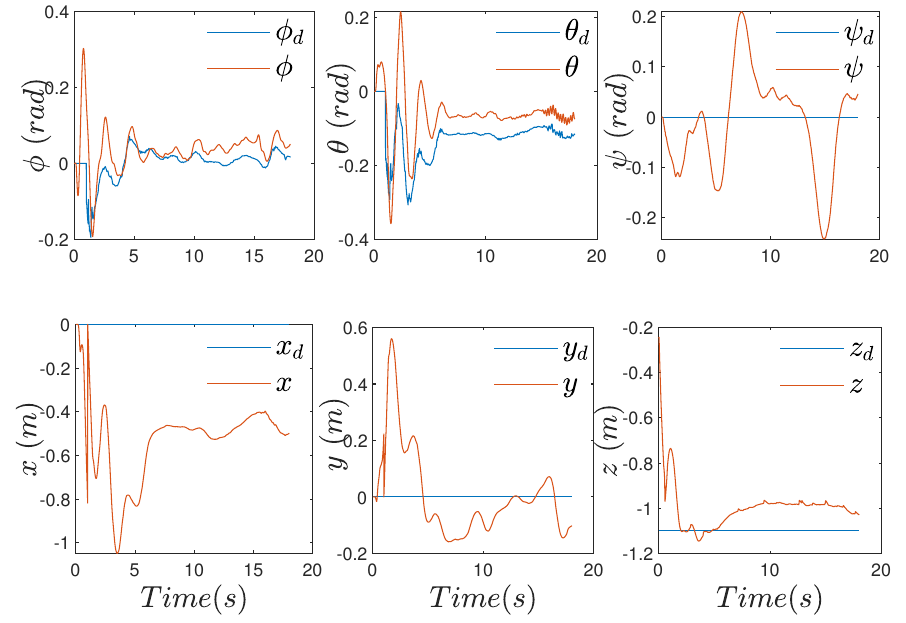
Figure 4. Hovering. Pose of the quadrotor MAV.